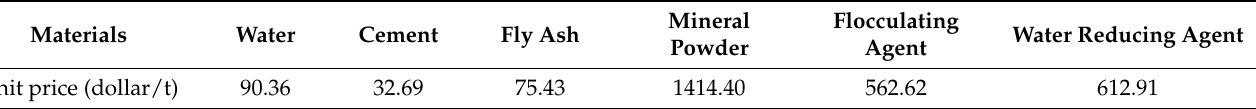
Table 8. NUC-FM Raw Material Price Details.